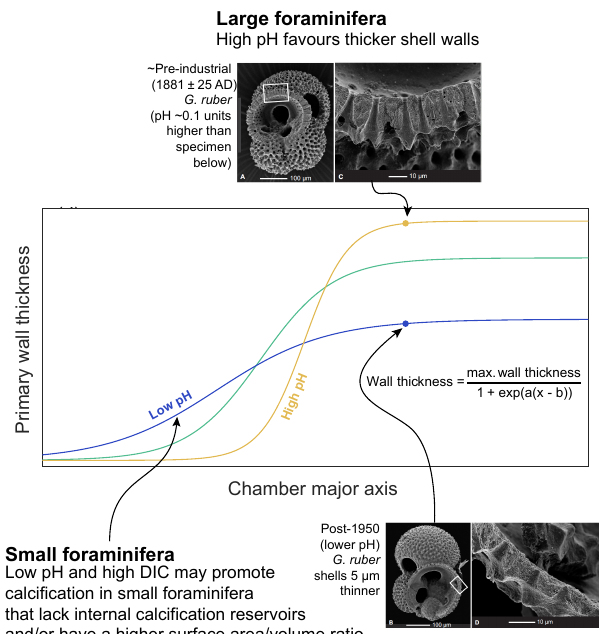
Figure 5. Schematic response of the chamber wall thickness- chamber size slope with carbonate chemistry, based on our obser- vations that (1) CI is controlled by pH in culture, and (2) mod- elled CI responds principally to the slope of this relationship, where shallower slopes are characterised by lower CI. These findings potentially reconcile the differential response of small and large foraminifera to acidification. For example, G. ruber in culture (this study) and the Arabian Sea (de Moel et al., 2009) respond negatively to reduced pH (blue line). Conversely, if benthic foraminiferal cal- cification can be considered analogous to planktonic, the positive calcification response small benthic species exhibit to acidification over the PETM and ETM2 (Foster et al., 2013) could support our hypothesised size-dependent calcification response. Images of G. ruber from de Moel et al. (2009) reproduced under CC3.0